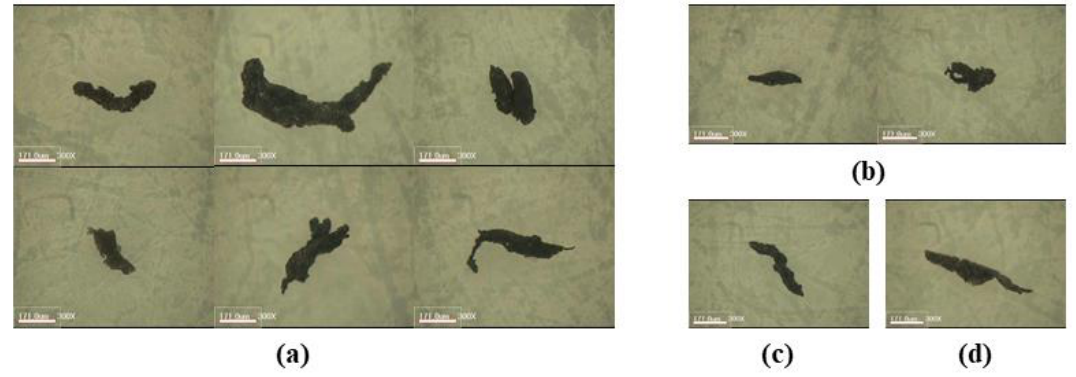
Figure 2. Magnified images of TRWPs selected from the road dust of 106 – 212 μm. ( a ) 1.20 – 1.30 g/cm 3 , ( b ) 1.30 – 1.40 g/cm 3 , ( c ) 1.40 – 1.50 g/cm 3 , and ( d ) 1.50 – 1.60 g/cm 3 . The scale bars are 171 μ m. ( b ) 1.30–1.40 g/cm 3 , ( c ) 1.40–1.50 g/cm 3 , and ( d ) 1.50–1.60 g/cm 3 . The scale bars are 171 µ